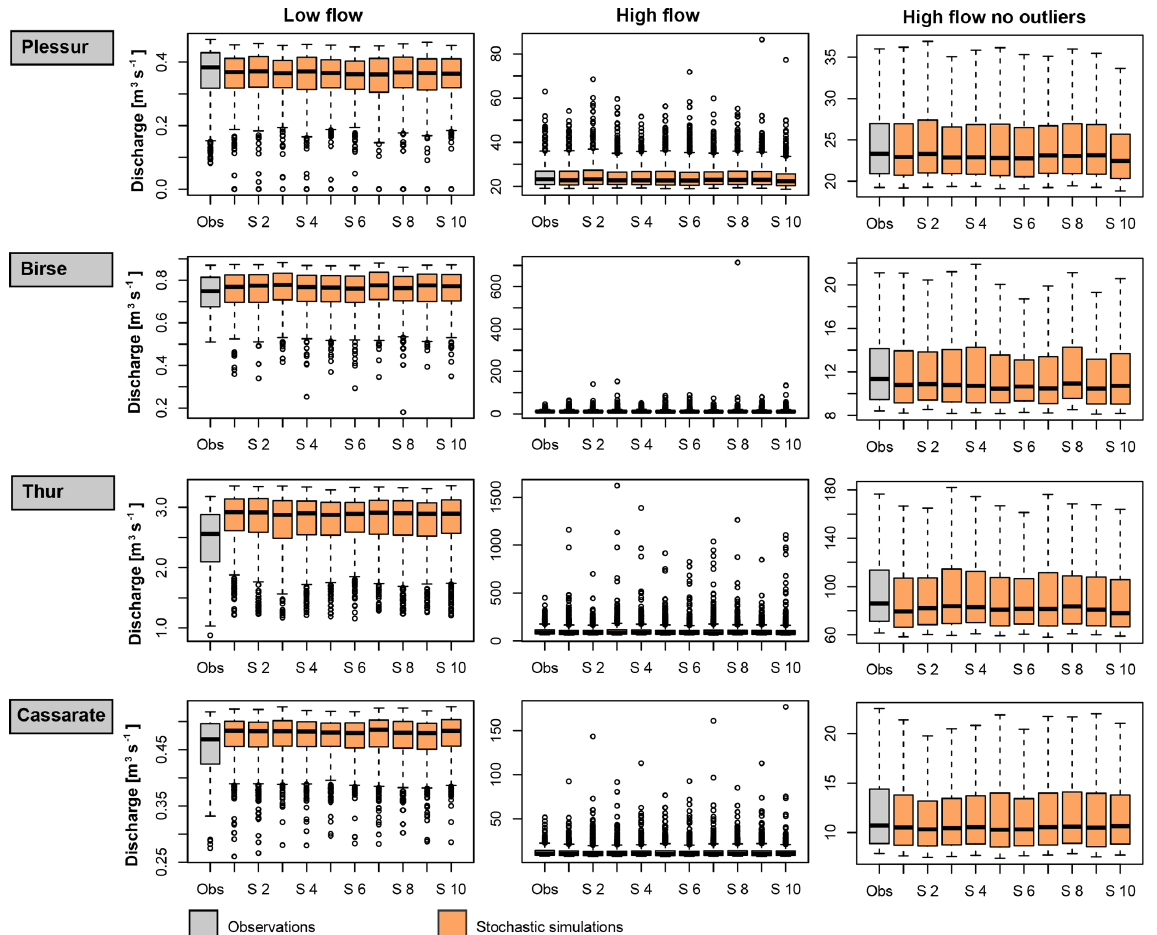
Figure 4. Low and high flows for observed (grey) and simulated (orange) time series for the four catchments Plessur, Birse, Thur, and Cassarate. The results are given for 10 simulation runs (S1–S10), and high flows are plotted with (middle column) and without (right column) outliers. Whiskers extend to the lowest/highest data point, which is still within 1.5 times the interquartile